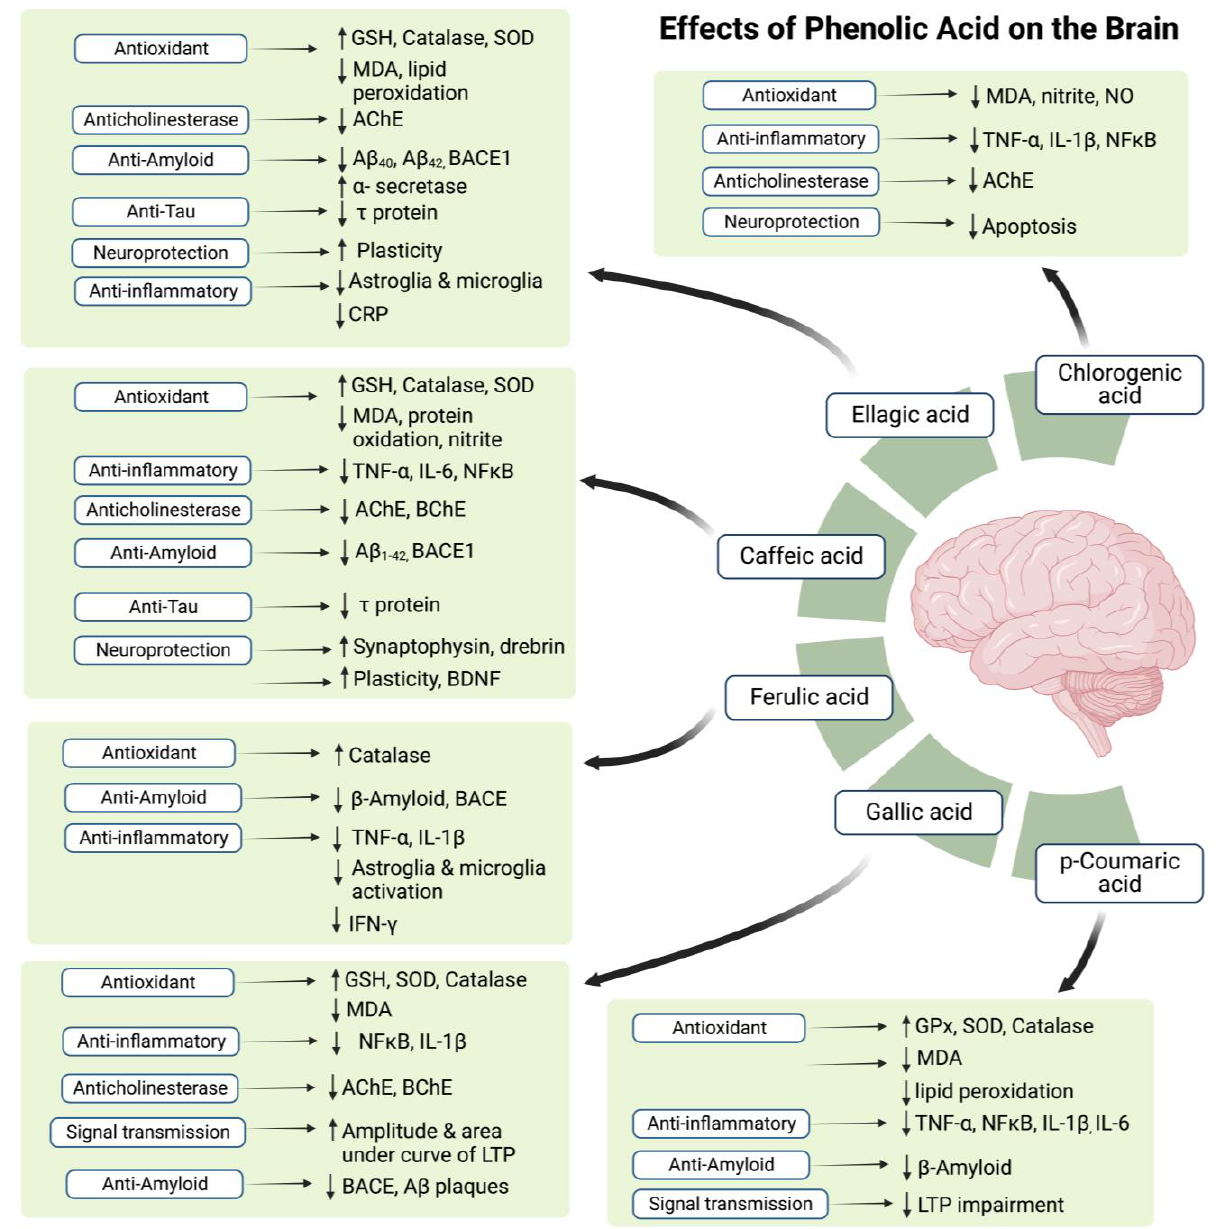
Figure 3. The possible effects of phenolic acids in honey on the brain. Symbol ( ↑ ) represents increase while ( ↓ ) represents decrease.